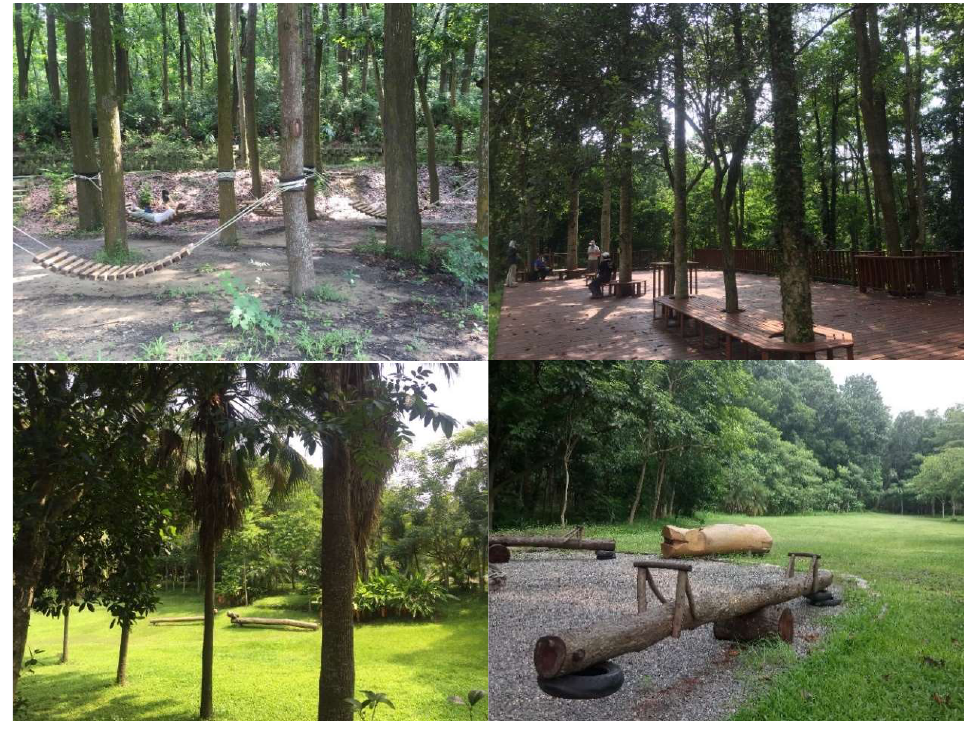
Figure 2. Landscapes of the Sinhua Forest Park.